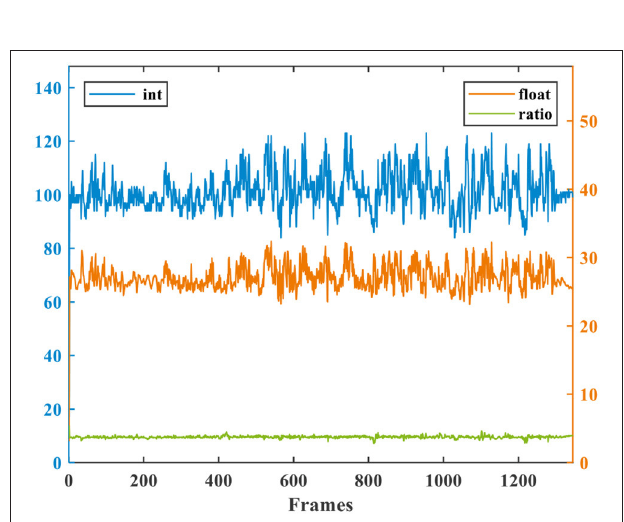
FIGURE 13 | The constant-scaling restriction for the data quantization of recurrent